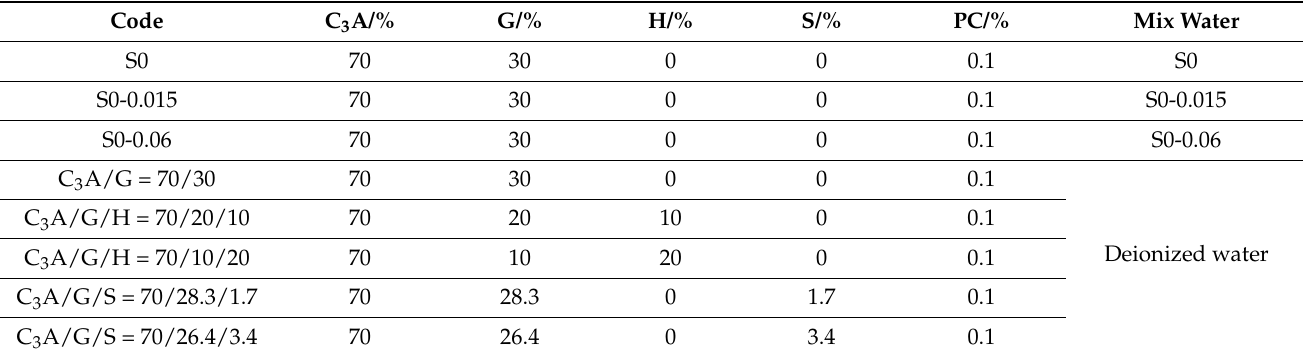
Table 3. Mixture proportions and codes for C 3 A hydration in the first